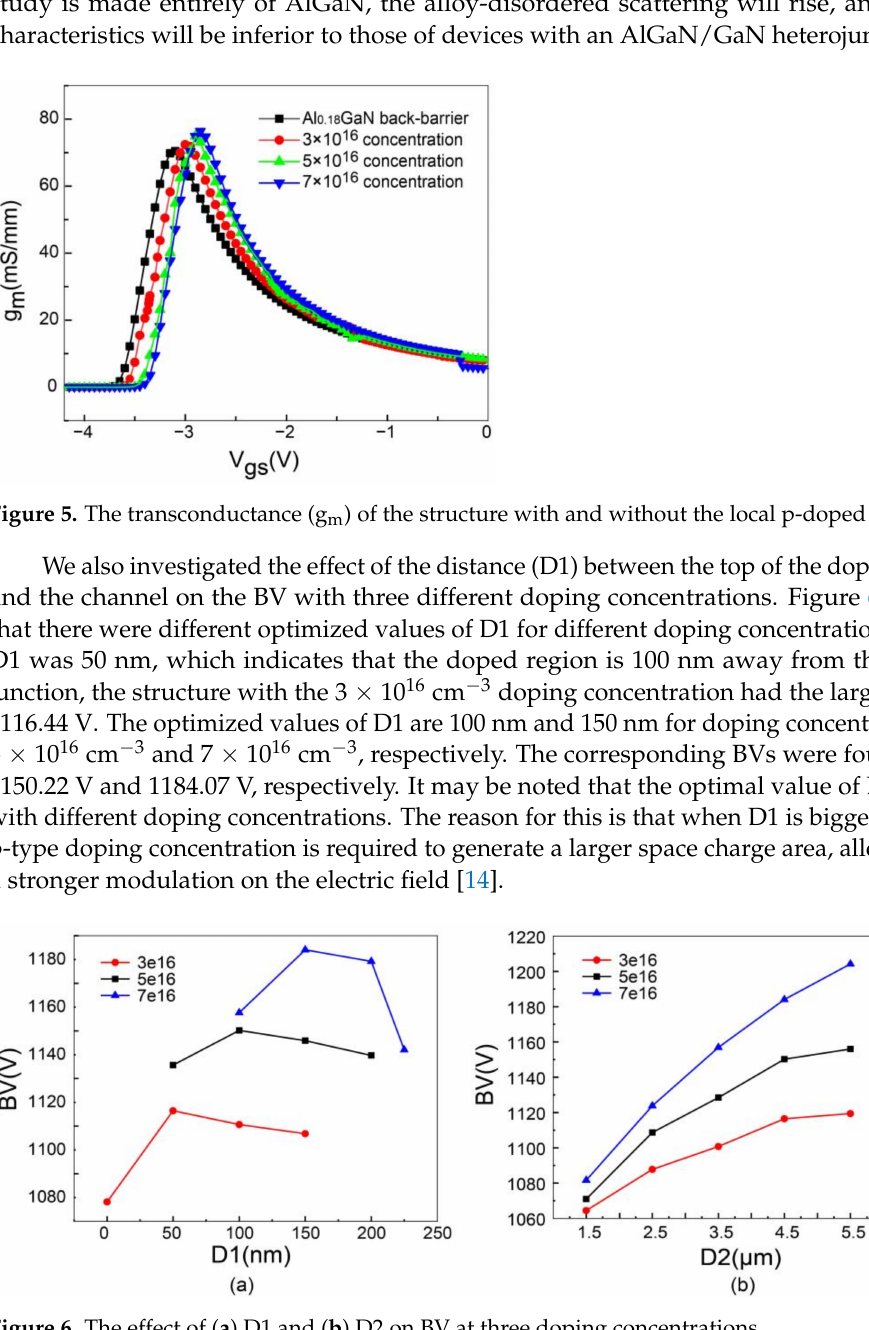
Figure 6. The effect of ( a ) D1 and ( b ) D2 on BV at three doping